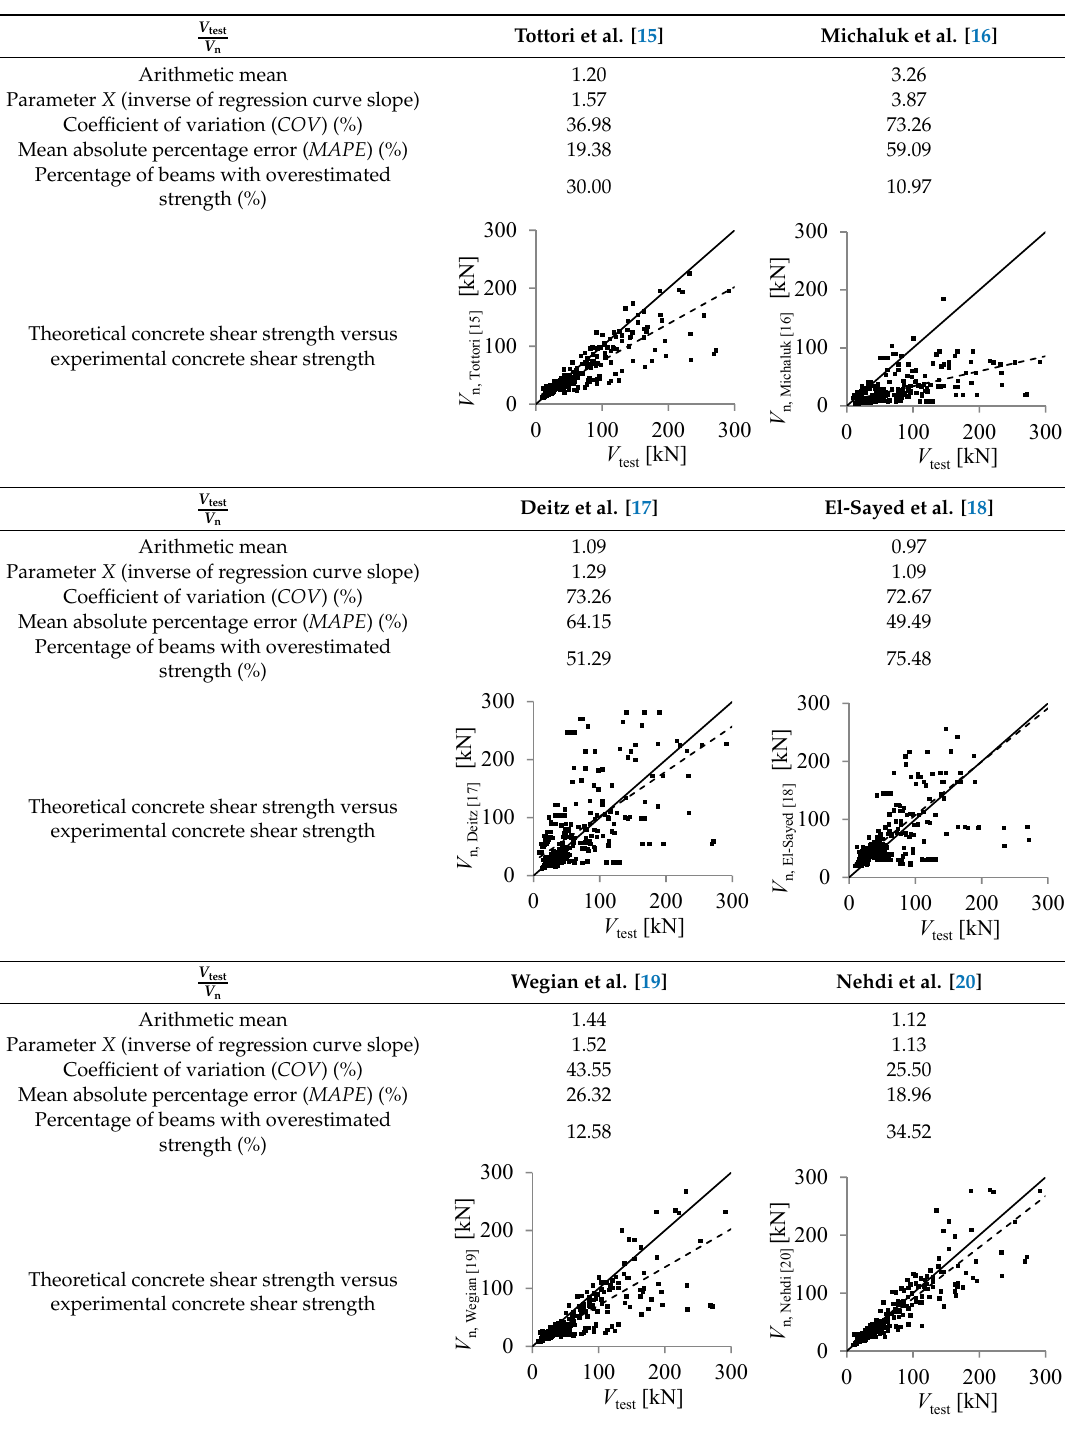
Table 4. Comparison of experimental ( V test ) and theoretical ( V n ) values of the concrete shear strength for algorithms proposed by other authors. Results according to Equations (1), (3)–(6), (8)–(12), (14)–(16) and